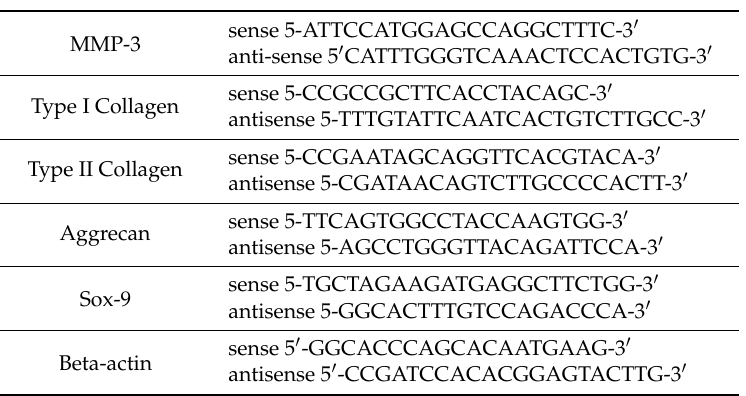
Table 1. Sequence of